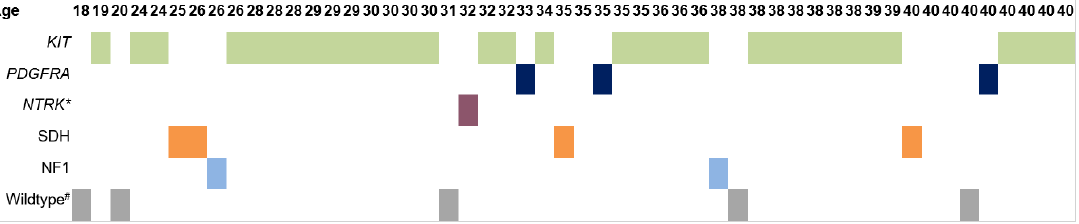
Figure 3. Distribution of mutation status among our young adult cohort * ETV6-NTRK3 gene fusion. # Wildtype for at least KIT and PDGFR .